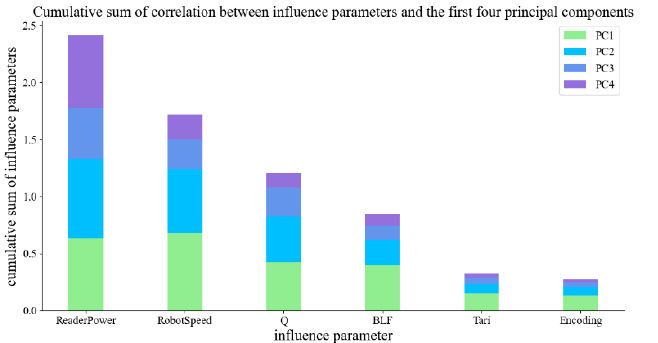
Figure 10. Cumulative sum of the correlations between influence parameters and the first four principal components.